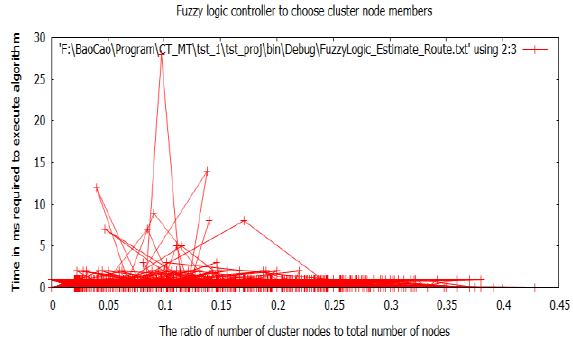
Figure 11. The simulation results of the fuzzy logic controller to choose cluster